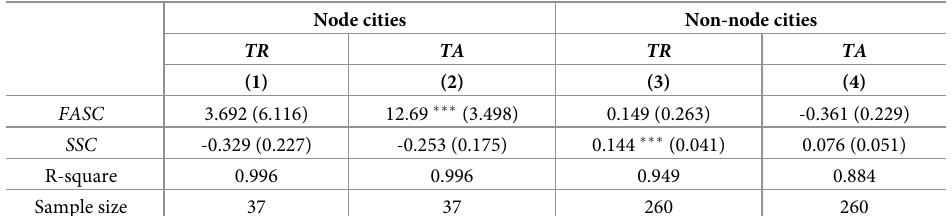
Note ��� , �� , and � represent significance levels of 1%, 5%, and 10%, respectively; the values in parentheses are robust standard errors clustered at the city level; TR = Tourism revenue; TA = Tourist arrivals; FASC = Food and accommodation supply capacity; SSC = Sightseeing supply capacity; other controls include ES = Economic scale; FE = Fiscal expenditure; TCD = Transportation convenience degree; IS = Industrial structure; SIS = Service industry support; PS = Population size; IL = Income level; OD = Opening degree; both city and year fixed effects are controlled in all the